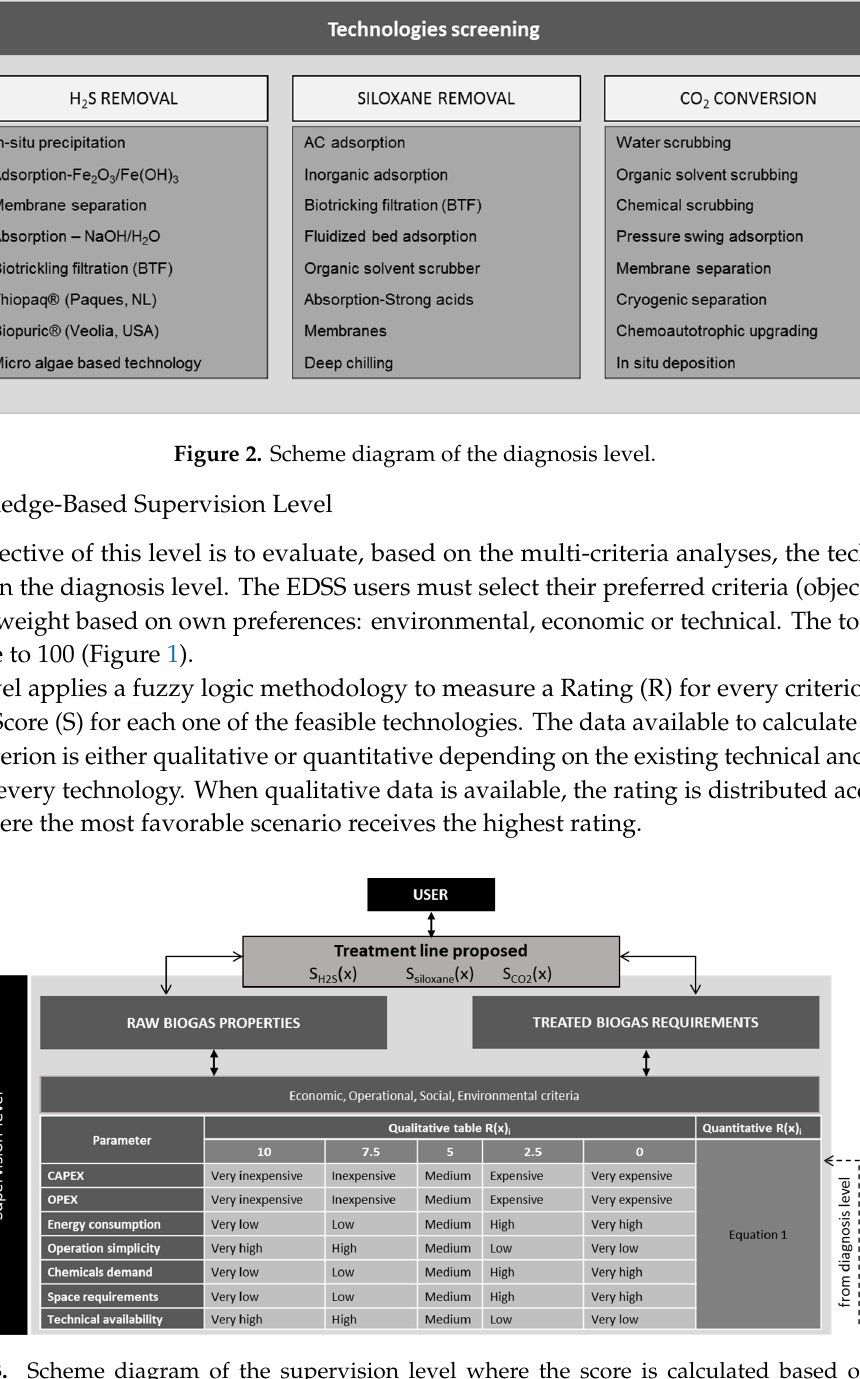
Figure 3. Scheme diagram of the supervision level where the score is calculated based on the multi-criteria analysis.